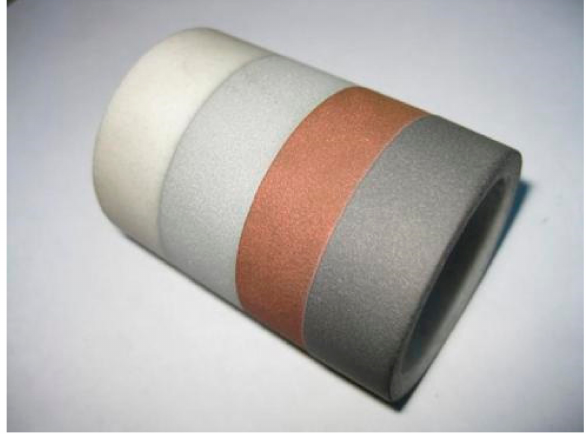
Figure 19. A Teflon item coated with aluminum, copper and WC / Co